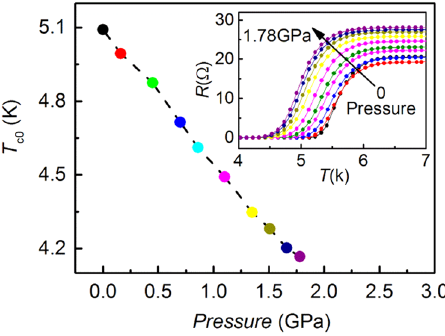
Fig. 5 Pressure dependence of zero-resistance transition tempera- ture. Inset: R xx -T curves at different